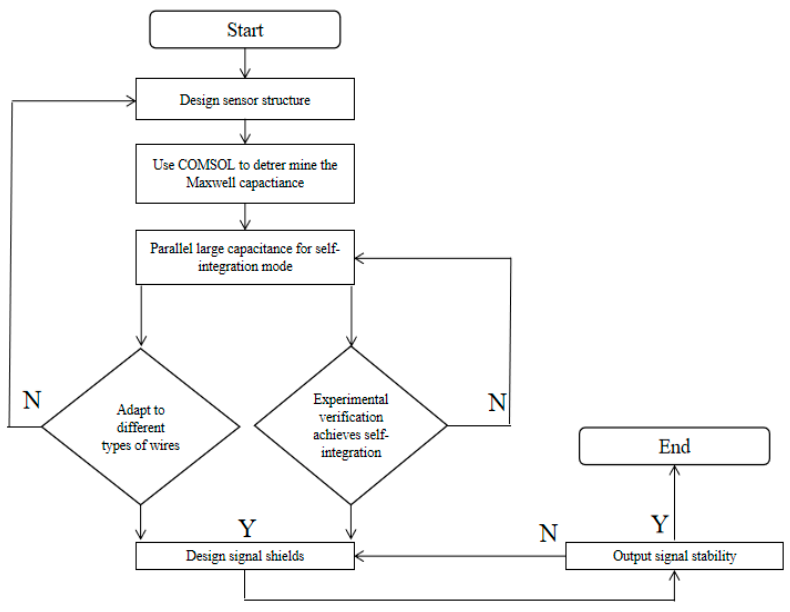
Figure 8. Flow Figure 8. Flow chart.